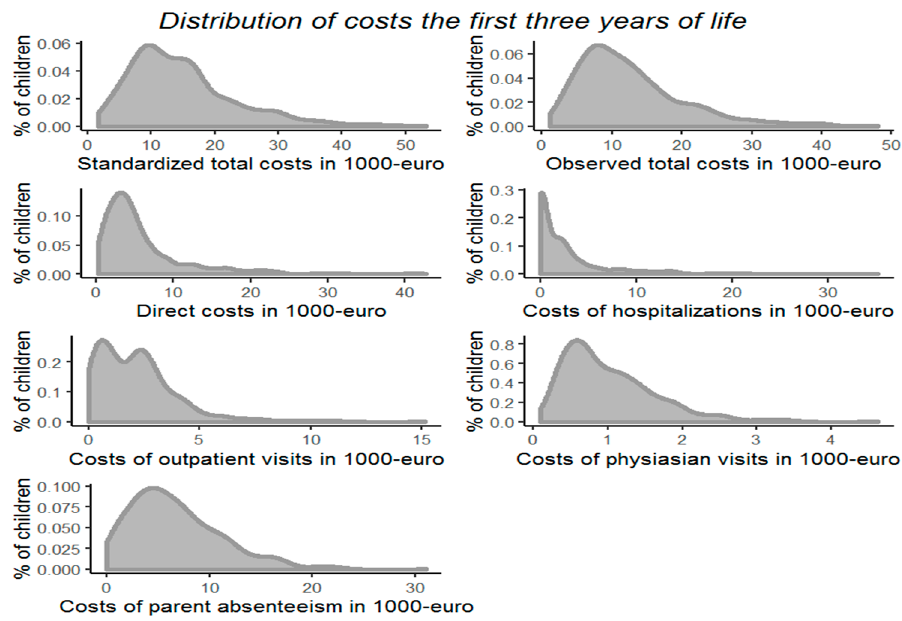
Figure 2. Distributions of costs. Distributions of costs during the first three years of life.